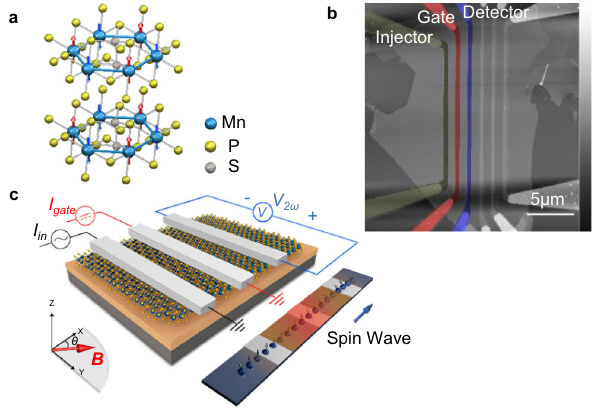
Fig. 1 Basics of a MnPS 3 magnon valve. a Atomic model of the crystal and spin structures of antiferromagnetic insulator MnPS 3 . b Atomic force micrograph of an MnPS 3 magnon valve device. The injector, gate, and detector electrodes are marked by dark green, red, and blue. c Artistic schematics of the thermal magnon generation, manipulation, and detection. The upper left section shows the device structure with external circuits and direction of the external in-plane magnetic fi eld; the lower right section shows propagation and modi fi cation of spin waves by the gate. Speci fi cally, I in : AC injection current; I gate : DC gate current; V 2 ω : the second harmonic thermal magnon inverse spin Hall signal; θ : the angle of the in-plane magnetic fi eld with respect to the x direction.